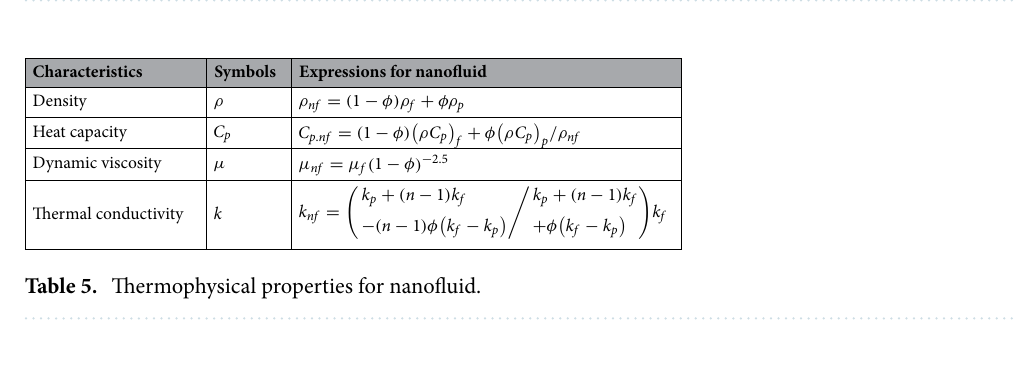
Table 4. Thermophysical features of the base fluid (distilled water) and nanoparticles ( TiO 2 ).